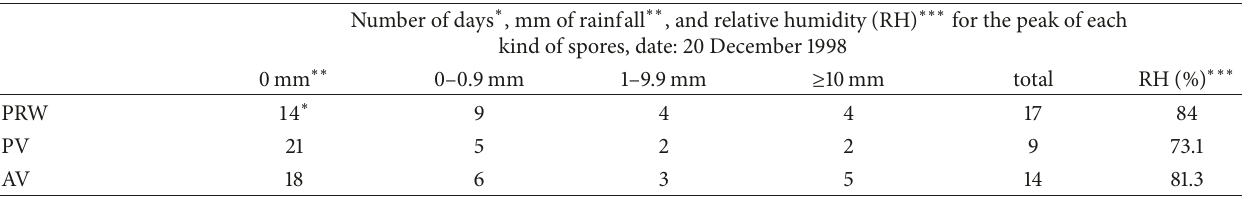
Table 4: Frequency of rain events corresponding to the peak of spores (PRW, PV, and AV) for the first period (1998-1999). Number of days ∗ , mm of rainfall ∗∗ , and relative humidity ( RH ) ∗∗∗ for the peak of each